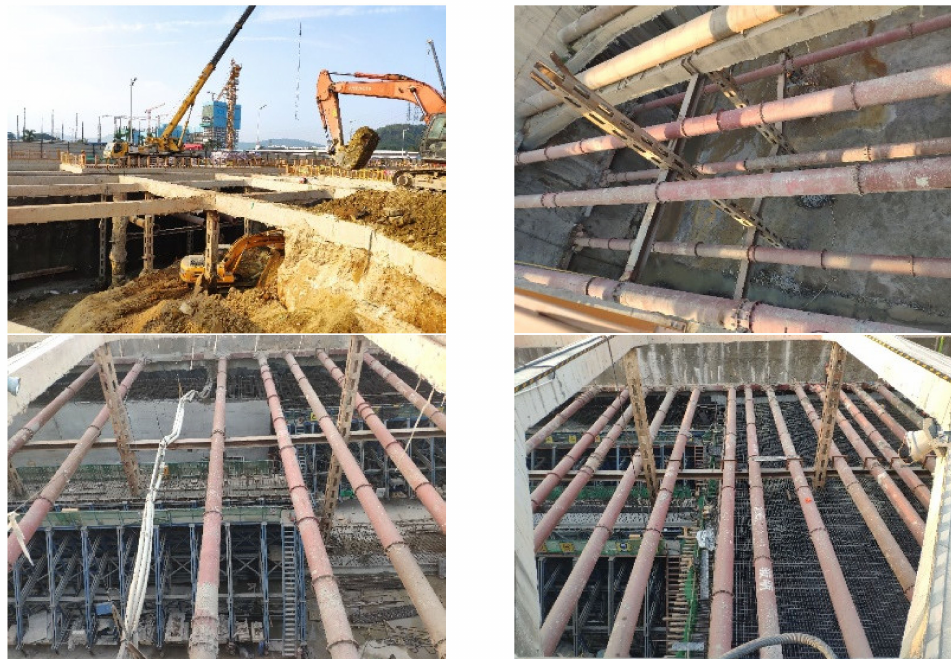
Figure 1. Construction site of the foundation pit under different